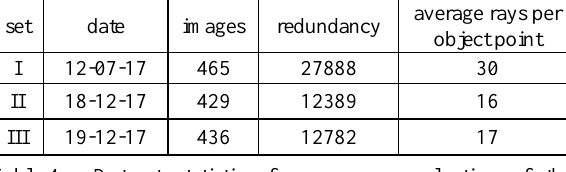
Dataset statistics for accuracy evaluation of